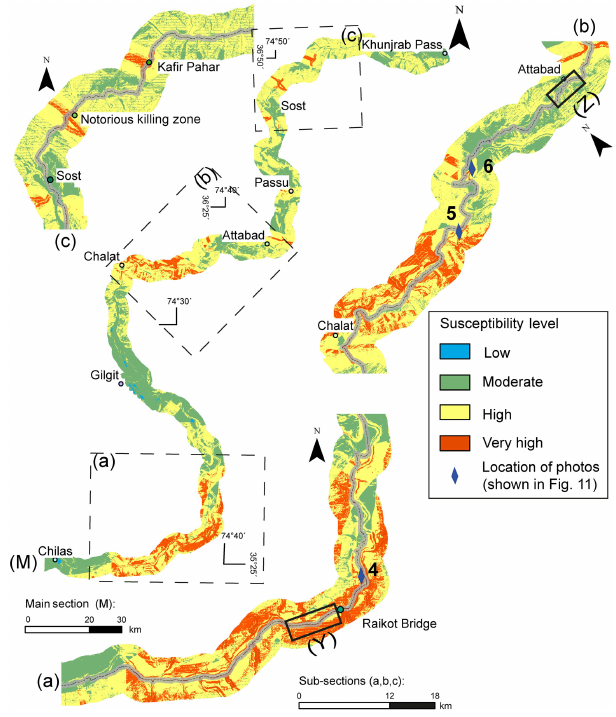
Figure 10. Landslide susceptibility map (Chilas–Khunjerab Pass): (a) Raikot Bridge section (box “Y” is shown in Fig. 14), (b) Attabad section (box “Z” is shown in Fig. 15) and (c) Sost